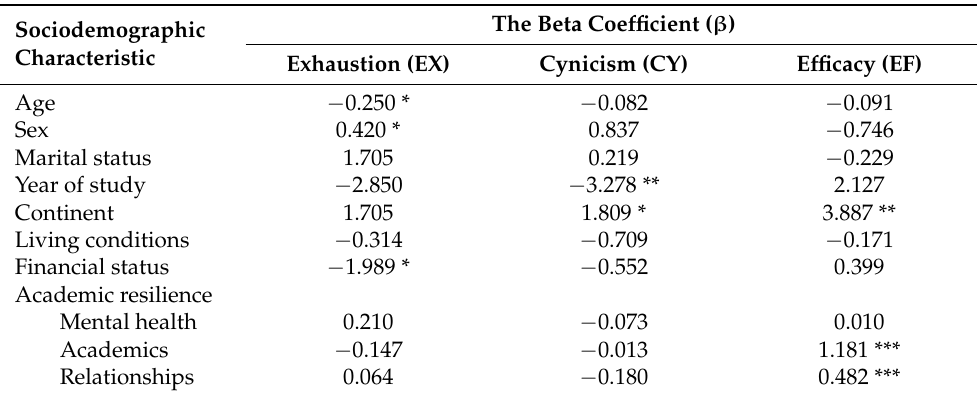
Table 9. Multivariable linear regression model of the relationship between academic resilience and academic